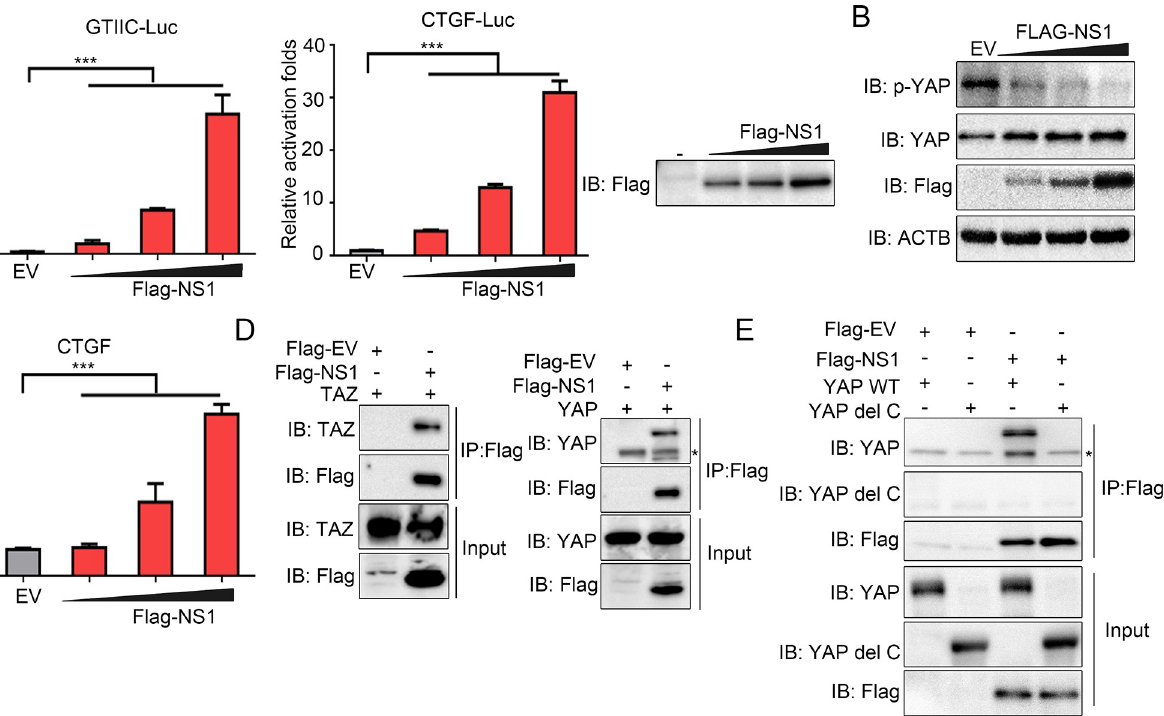
Fig 2. NS1 induces YAP/TAZ activation. (A) Luciferase reporter assays of GTIIC and CTGF reporter were conducted in A549 cells transfected with NS1 or EV plasmids for 24 hours. (B) A549 cells were transfected with different amounts of Flag-NS1 plasmid. WCL was analyzed by immunoblotting with indicated antibodies. (C) Flag-NS1 was transfected into A549 cells. WCL was subjected to RT-qPCR for CTGF expression. (D) 293T cells were co- transfected with TAZ or YAP plasmids, with Flag-NS1 and Flag-EV. WCL was subjected to immunoprecipitation with M2 beads, bound proteins and input lysis were analyzed by immunoblotting with indicated antibodies. � , nonspecific bands. (E) YAP WT or YAP del C plasmids were co-transfected with Flag-NS1 or Flag-EV into HEK293T cells. WCL was subjected to immunoprecipitation with M2 beads, followed by immunoblotting. � , nonspecific bands. All experiments were repeated at least three times. Data in (A) and (C) are presented as means ± SD. � p < 0.05, �� p < 0.01, ��� p <